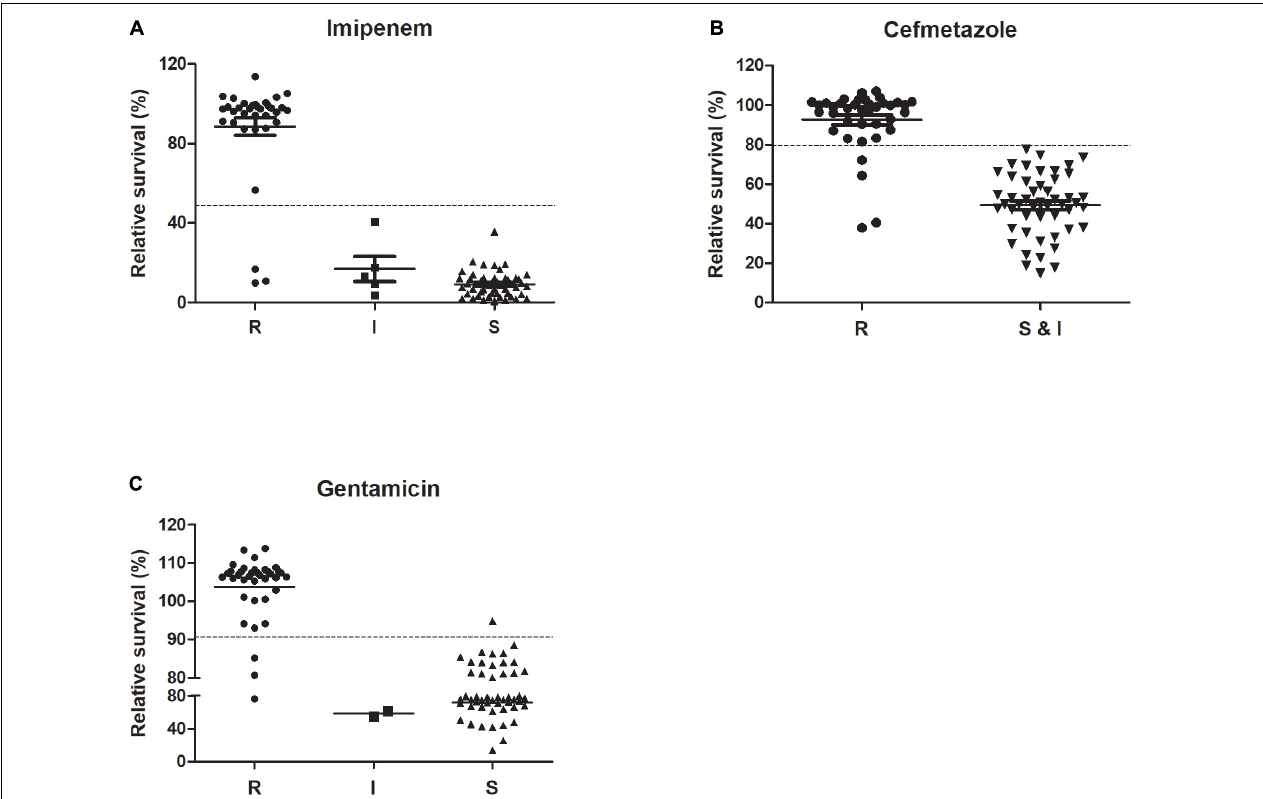
FIGURE 3 | Performance of ultra-rapid SYBR Green/PI stain in distinguishing among R (resistant), I (intermediate), and S (sensitive) isolates of K. pneumoniae against imipenem, cefmetazole, and gentamicin. Antibiotics (A) imipenem (50 mg/L) and (B) cefmetazole (400 mg/L) were added to 89 overnight cultures of clinical strains of K. pneumoniae diluted to OD 600 0.1. The antibiotic (C) gentamicin (400 mg/L) was added to 89 log phase clinical strains of K. pneumoniae diluted to OD 600 0.05. After incubation with antibiotics for 30 min (A,B) or 60 min (C) , SYBR Green/PI staining was performed and relative membrane permeability rates (RS) were calculated and compared among their respective susceptibility categories (Student’s t -test analysis for (B) and ANOVA test for (A,C) , * p <